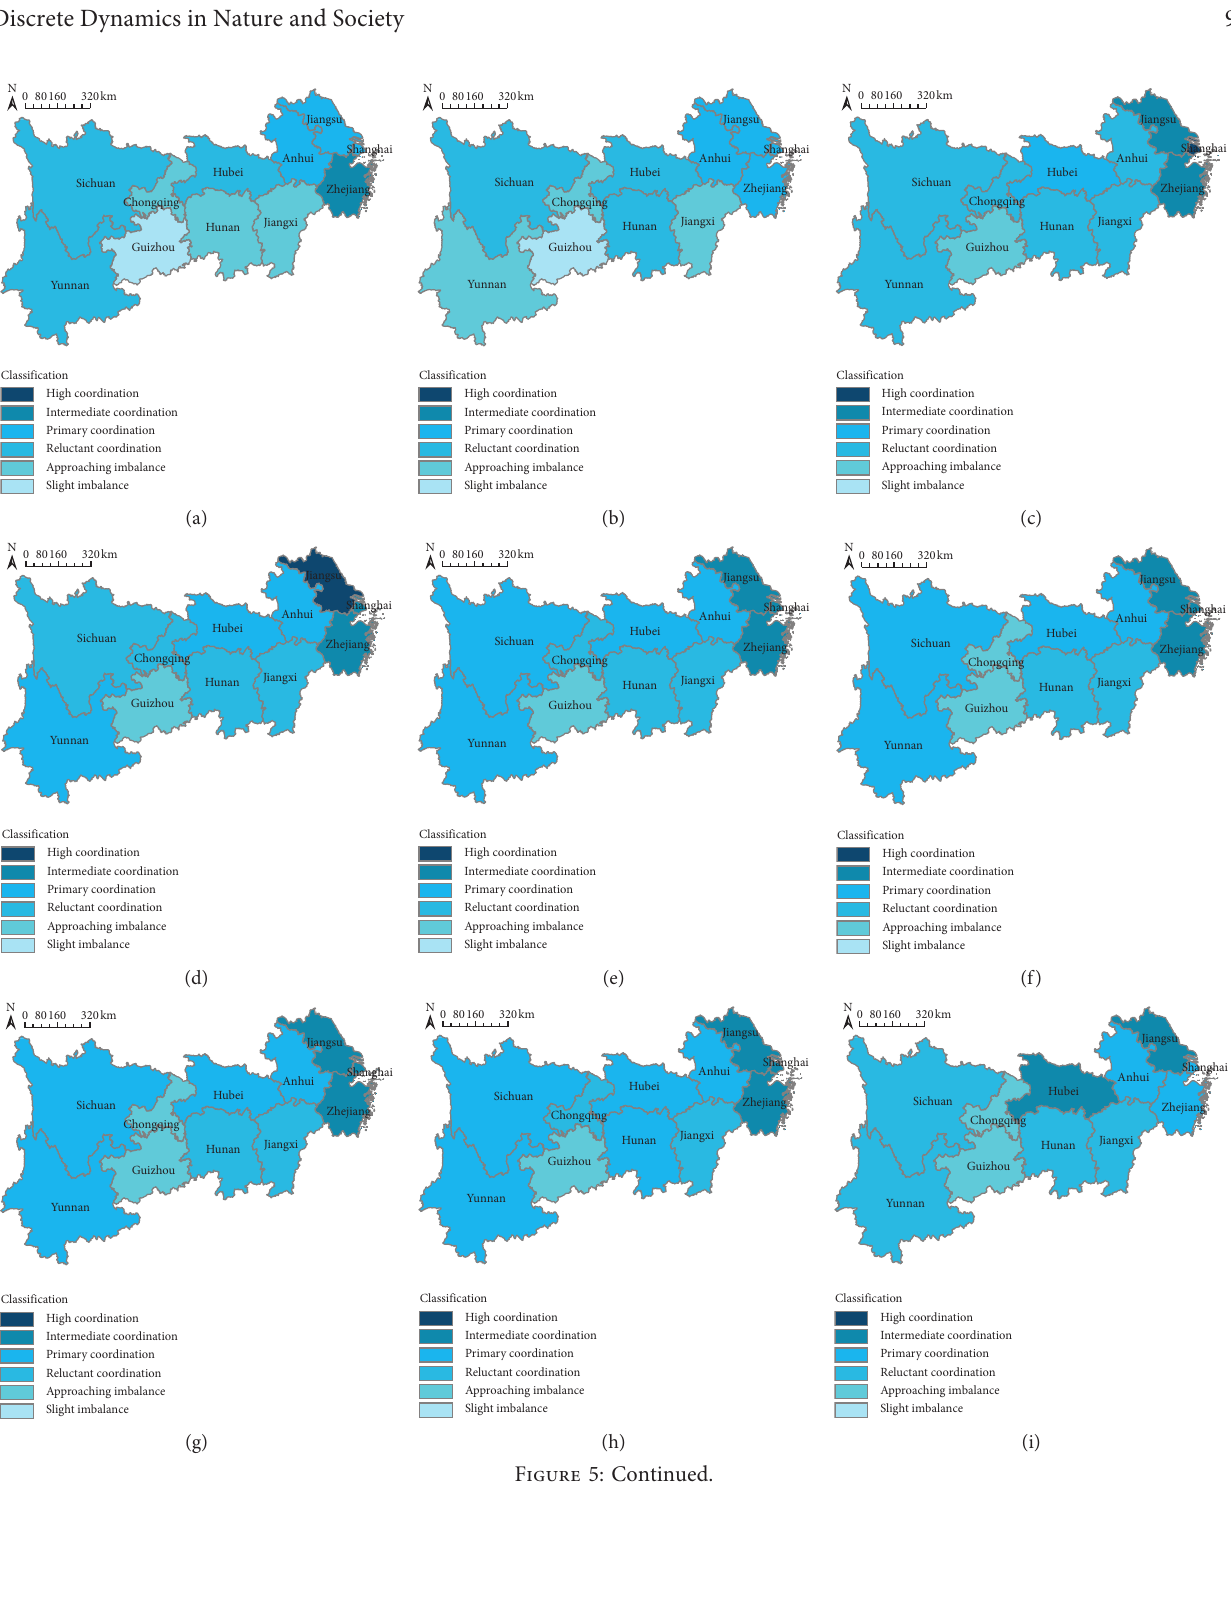
coordination Intermediate coordination Primary